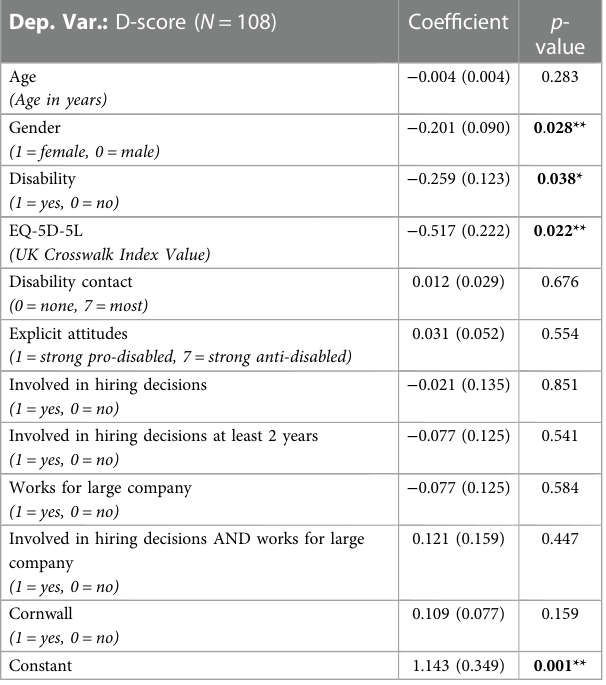
TABLE 5 Regression analysis with disability IAT score as dependent variable. Dep. Var.: D-score ( N =